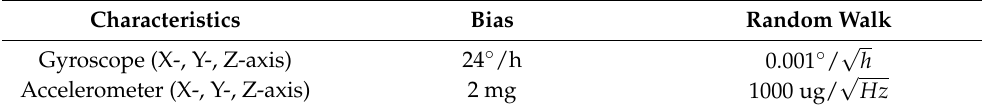
Table 1. Parameters of the sensors in simulation experiment.